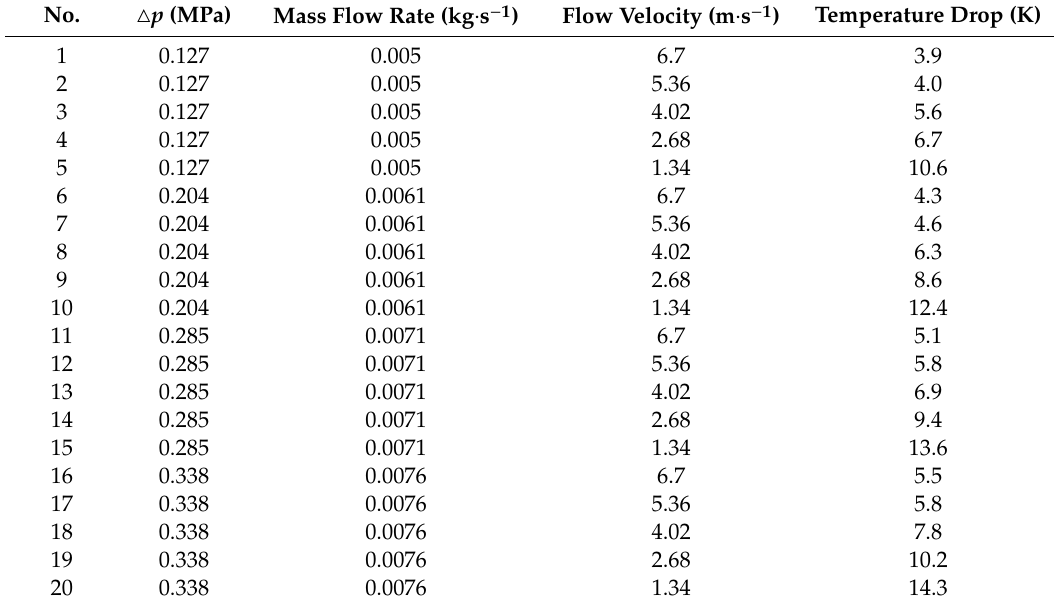
Table 1. Temperature drops under di ff erent airflow velocities and LN 2 mass flow rates. No. (cid:52) p